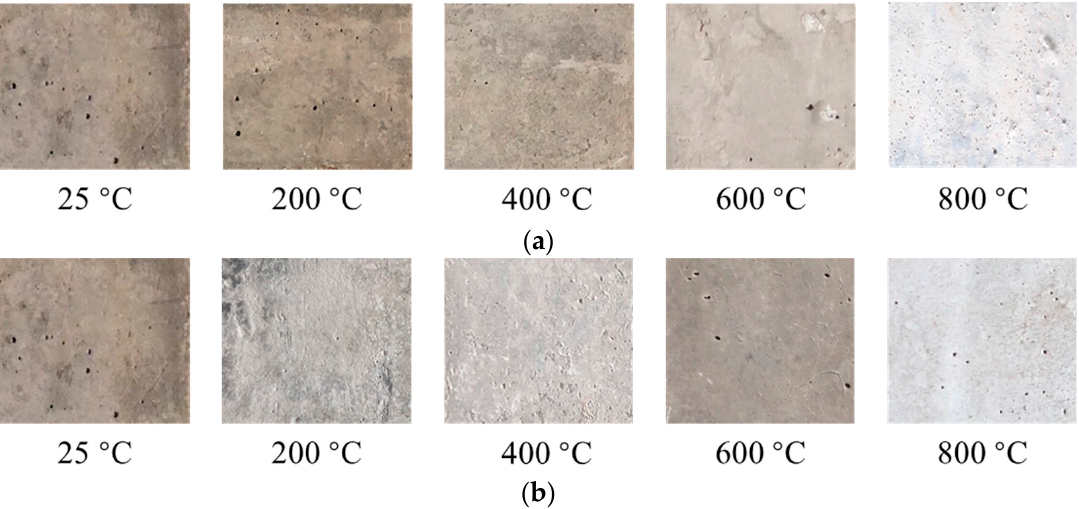
Figure 2. Color changes of specimens subjected to different cooling methods. ( a ) Cooling at room temperature. ( b ) Cooling with water.